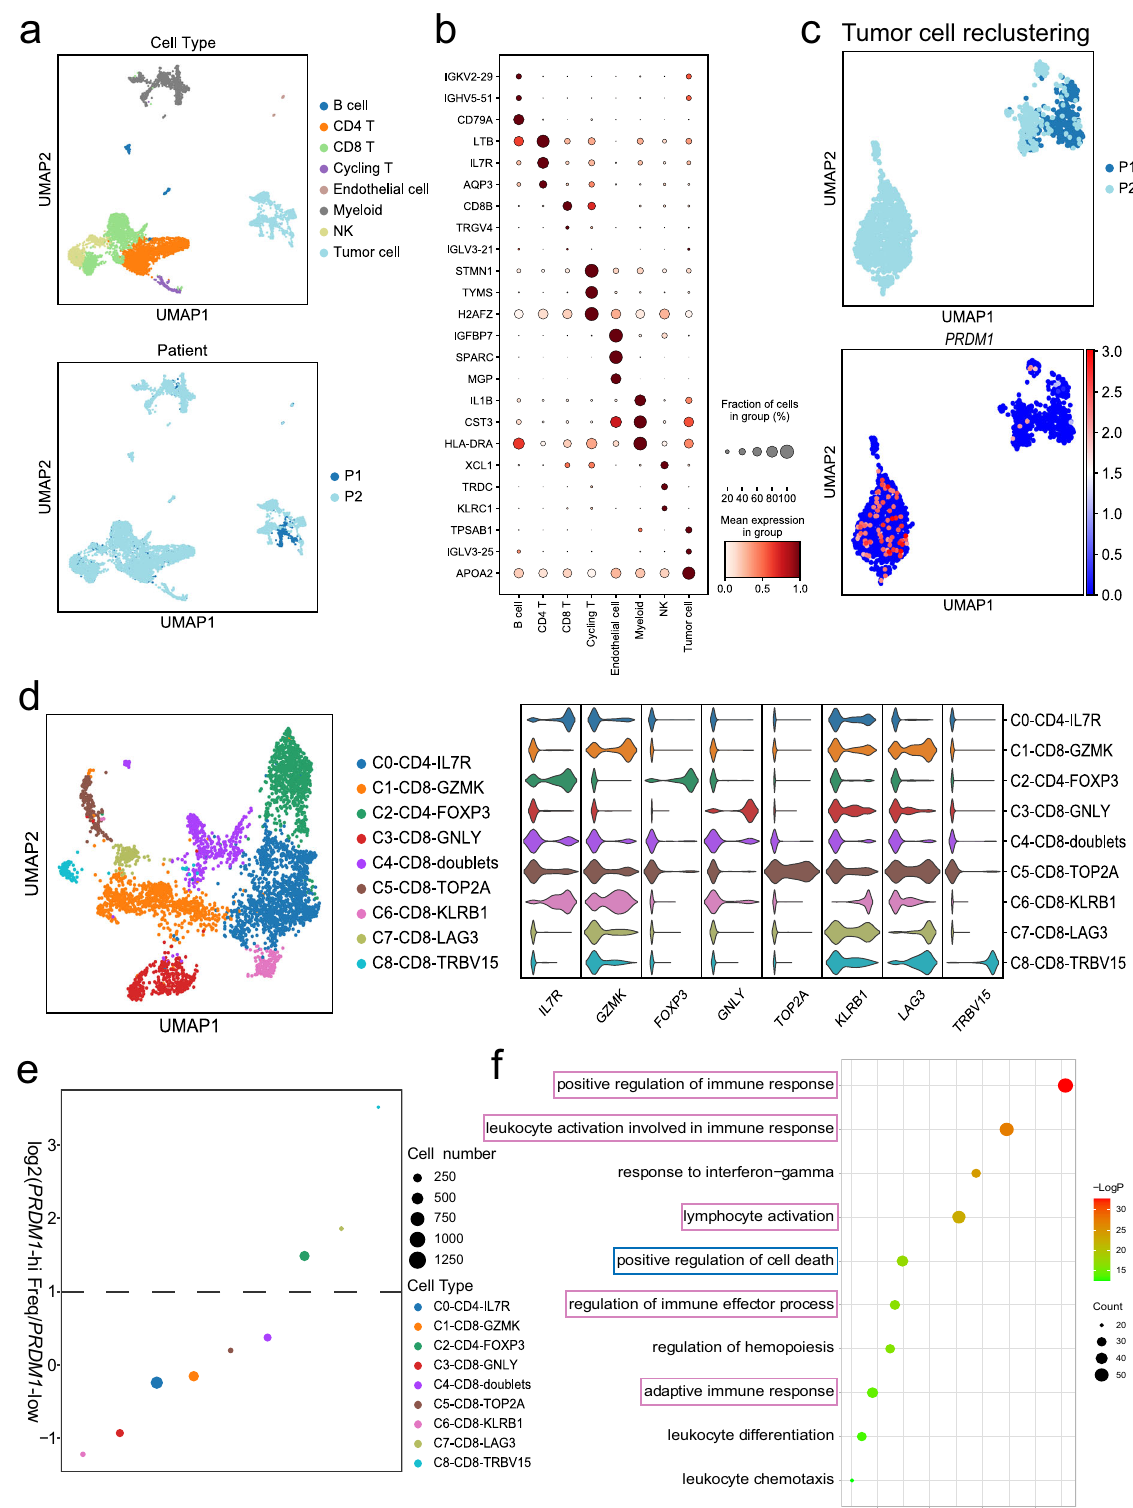
Fig. 8 | Single-cell analysis of intra-tumoral cell populations. a In total, 8 cell types were identi fi ed and shown using UMAP. The colors were coded by cell types (top) and patients (bottom). b Dot plot showing the top marker genes of each cell type. c UMAP plots (top) and PRDM1 expression (bottom) in malignant cells from